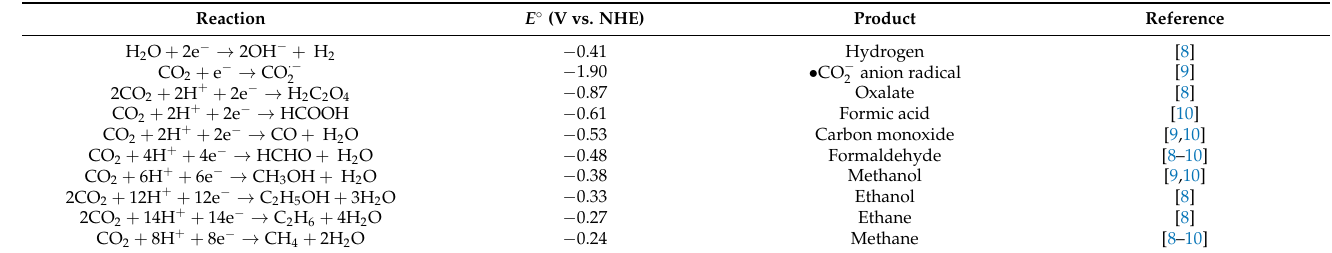
Table 1. Main products of CO 2 reduction and the corresponding potential (pH =